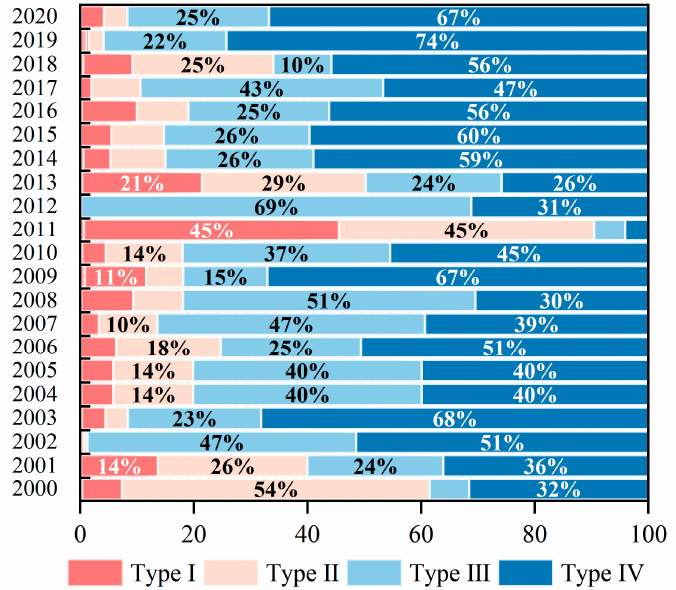
Figure 5. Inter-annual trends of the coupling types of drought and waterlogging in Songliao Plain for 2000–2020.